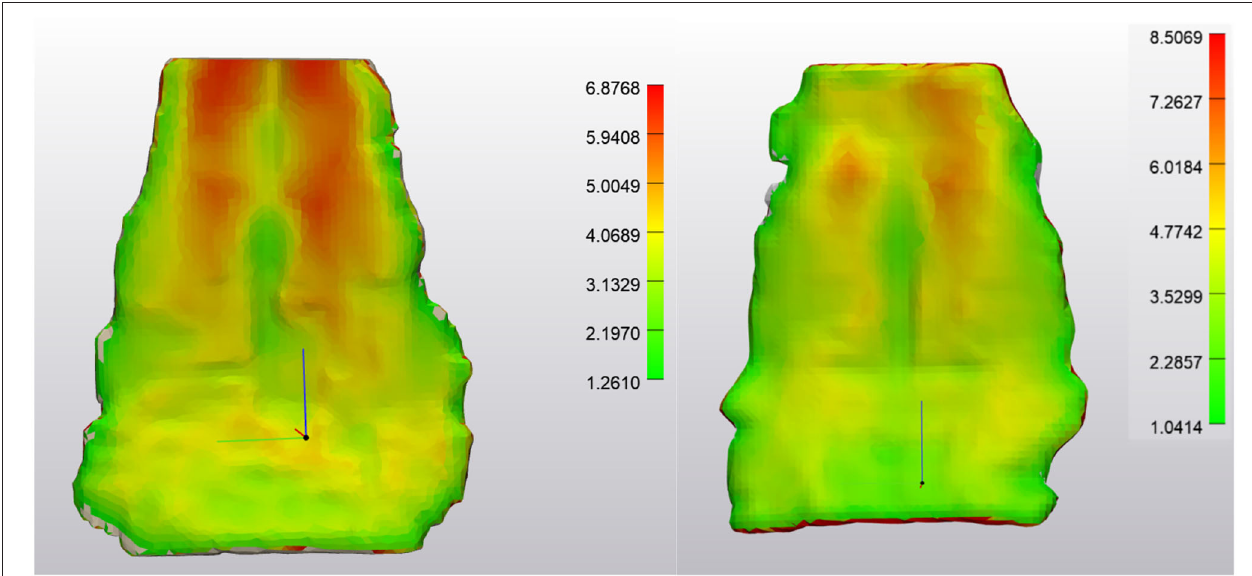
FIGURE 2 | NORMAL Deep Digital Flexor Tendon. (Left) Dorsopalmar tendon thickness evaluation at first time point (after wrapping and smoothing algorithm applied). Measurements are in mm. Note the change in thickness between the bilobed tendon structure proximally to the flat distal portion of the segment. Thickness range is 1.26–6.88mm. (Right) Tendon thickness evaluation from the same horse 7 months later. Thickness range 1.04–8.50mm. Top of the image represents the proximal aspect of the tendon.